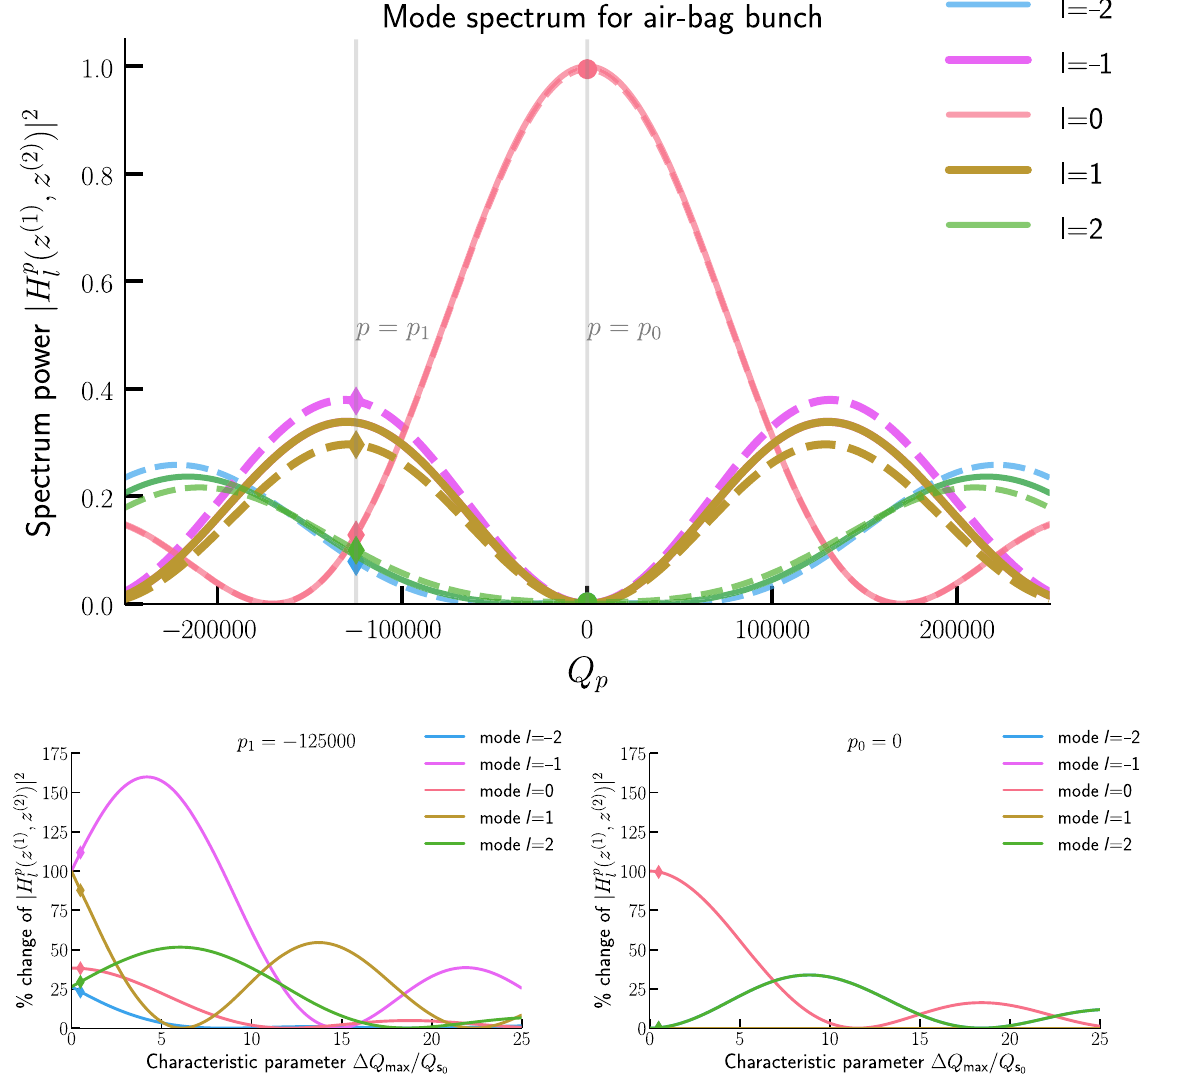
FIG. 2. Top: head-tail mode spectra j H p ð z ð 1 Þ ; z ð 2 Þ Þj 2 for an airbag bunch, unperturbed (solid lines), and with the effect of a PEL l 0 . 5 (bottom). Dependency of mode power spectrum on the PEL strength Δ Q =Q (dashed lines) for Δ Q max s 0 ¼ j l j ¼ f 0 ; 1 g are near their